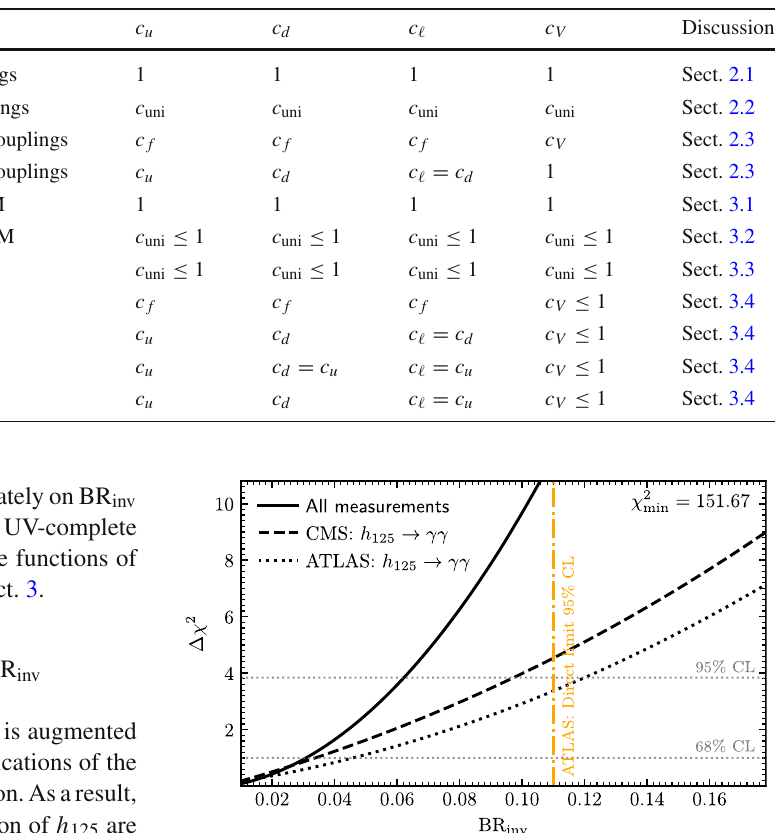
boson measurements for all possible values of BR inv .